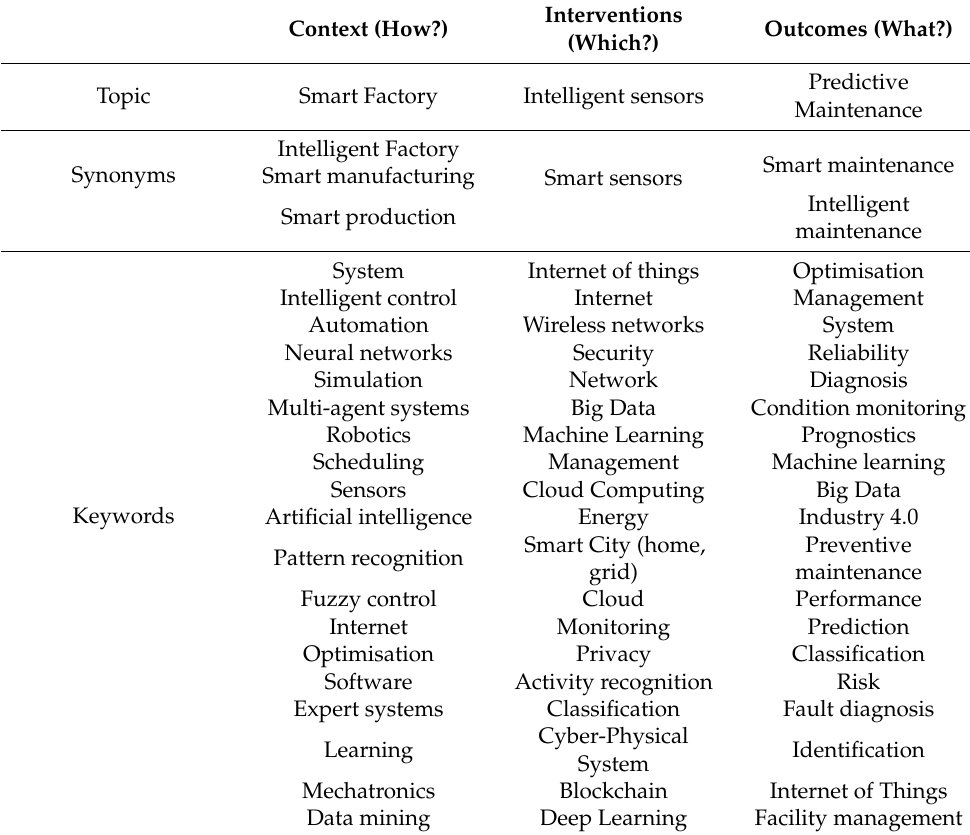
Table 1. PICO (Problem/context, Intervention, Comparison, Outcomes) logic grid.